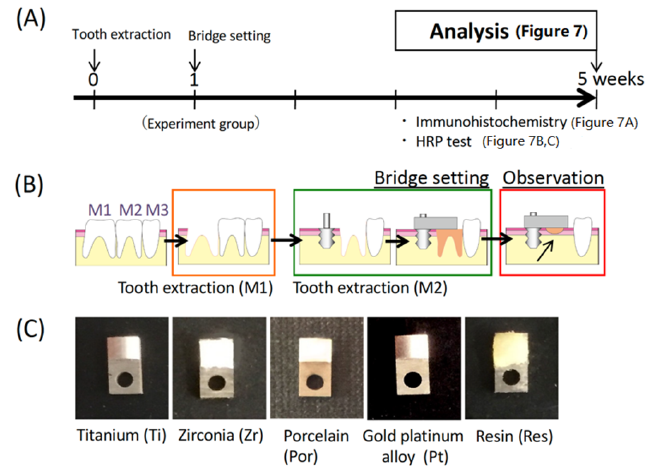
Figure 6. Selecting the most effective material for the bridge pontic base. ( A ) Experimental protocol. ( B ) Experimental model. ( C ) The five materials used in the